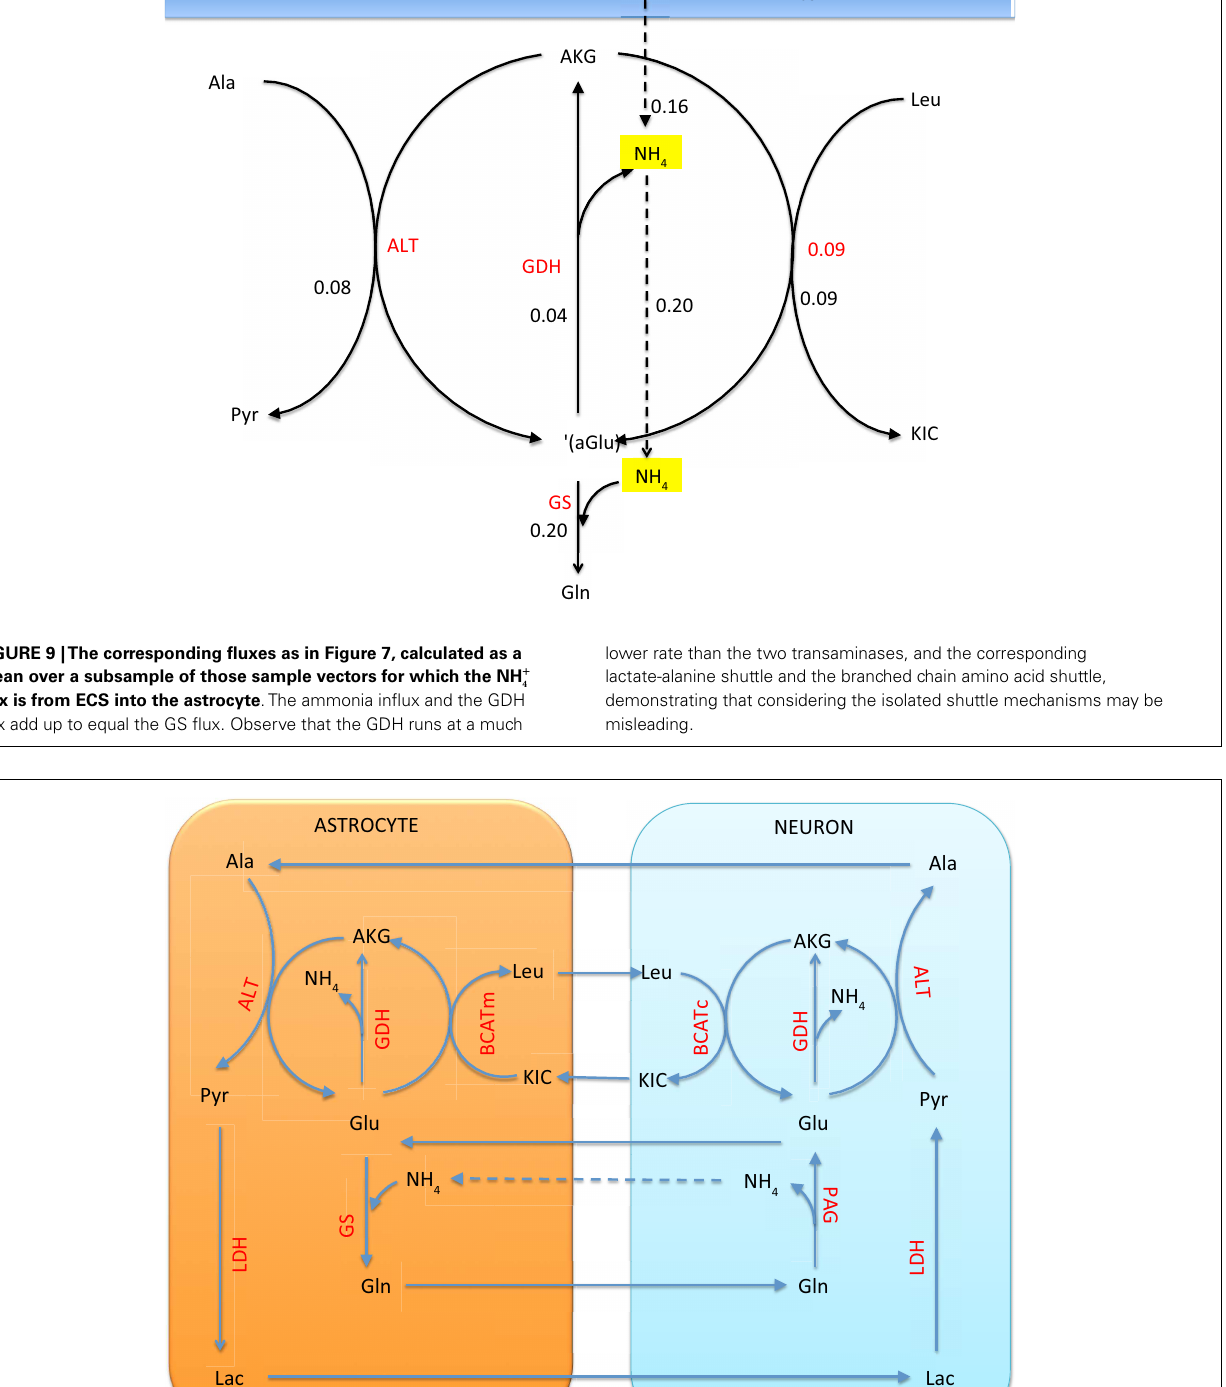
FIGURE 10 |The branched chain amino acid cycle can provide a stoichiometrically viable alternative for the traditional glutamate-glutamine cycle . Leucine is transported from astrocyte to neuron, where it is transaminated to α -ketoisocaproate, forming glutamate from α -ketoglutarate. Unlike the glutamate-glutamine cycle, this cycle